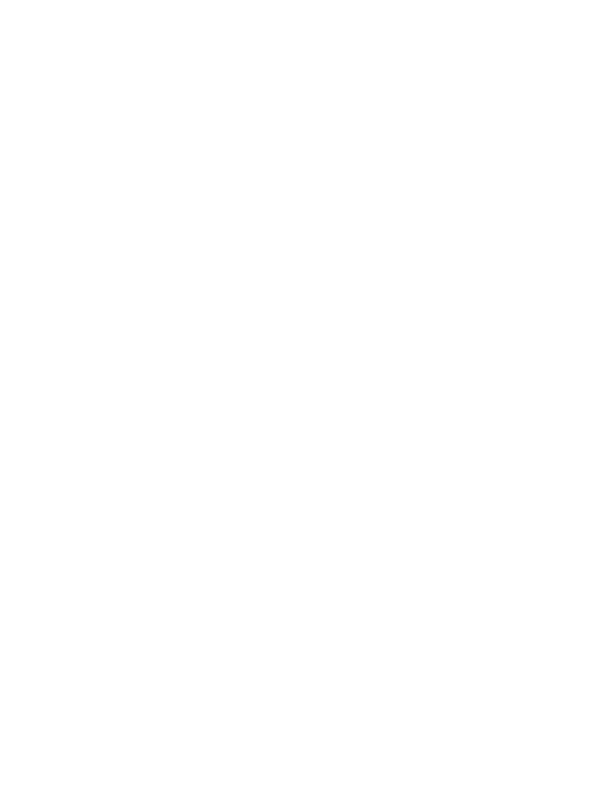
TABLE A2 | Hyperparameter values for content based and hybrid KNN recommender